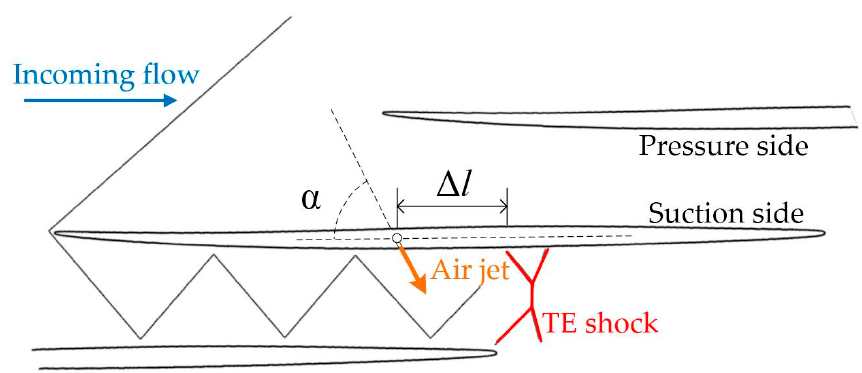
Figure 2. Sketch map of the air jet control scheme and its geometrical definitions.